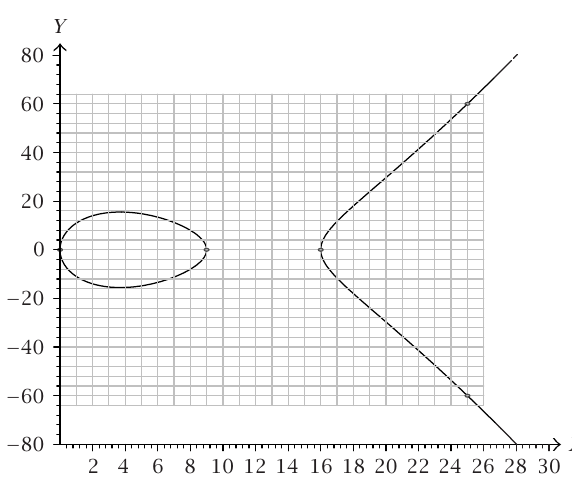
Figure 9.1 Elliptic curve E : Y 2 = X(X − 9 )(X − 16 )